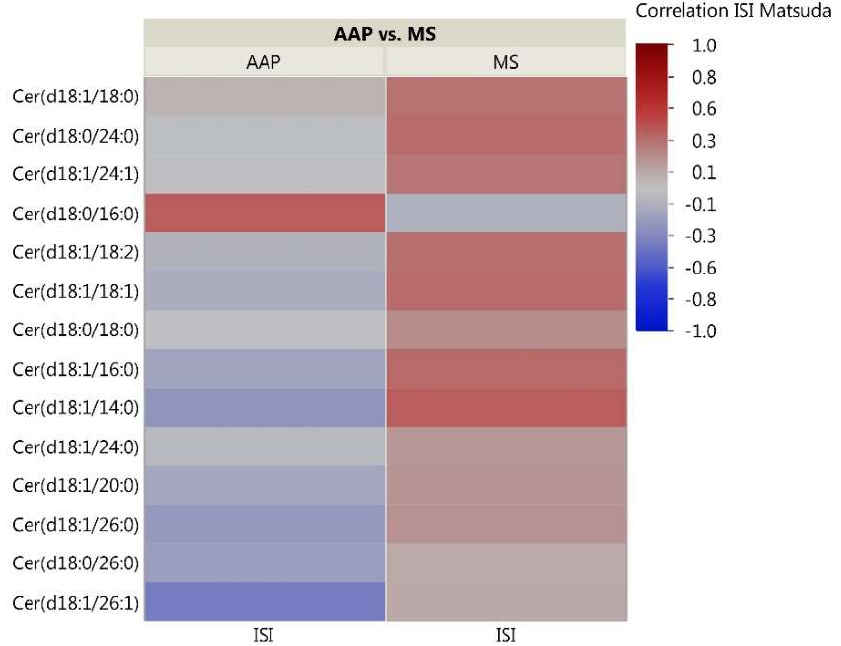
Figure 4. Correlation heatmap of insulin sensitivity and CER lipids. The heatmap shows degree of correlation between individual CER species and insulin sensitivity measured by the Matsuda ISI. Lipids are ordered by the average ascending correlation value. AAP: atypical antipsychotic, and MS: mood stabilizer.